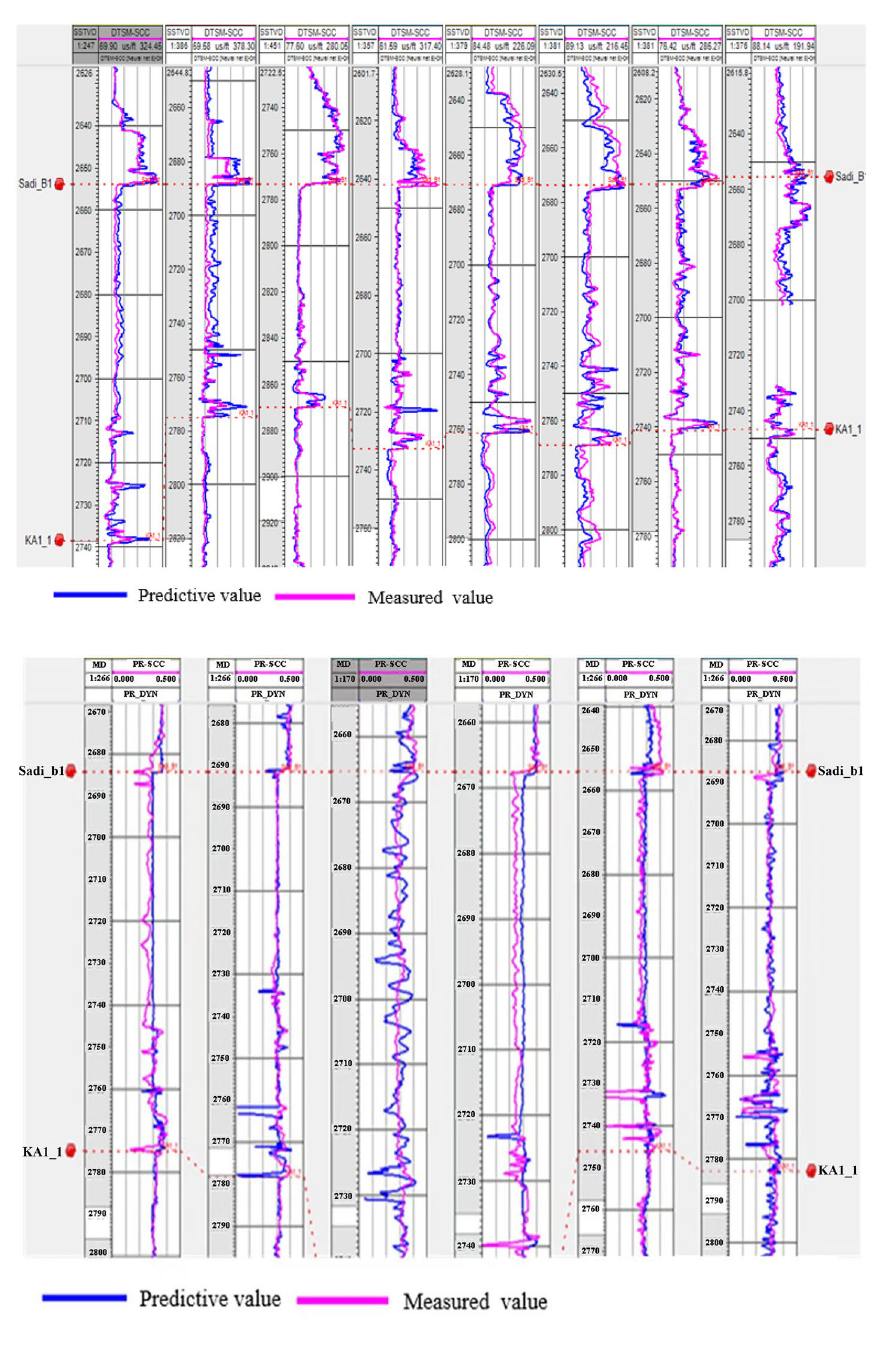
Fig. 6 Comparison between measured and predicted shear wave data